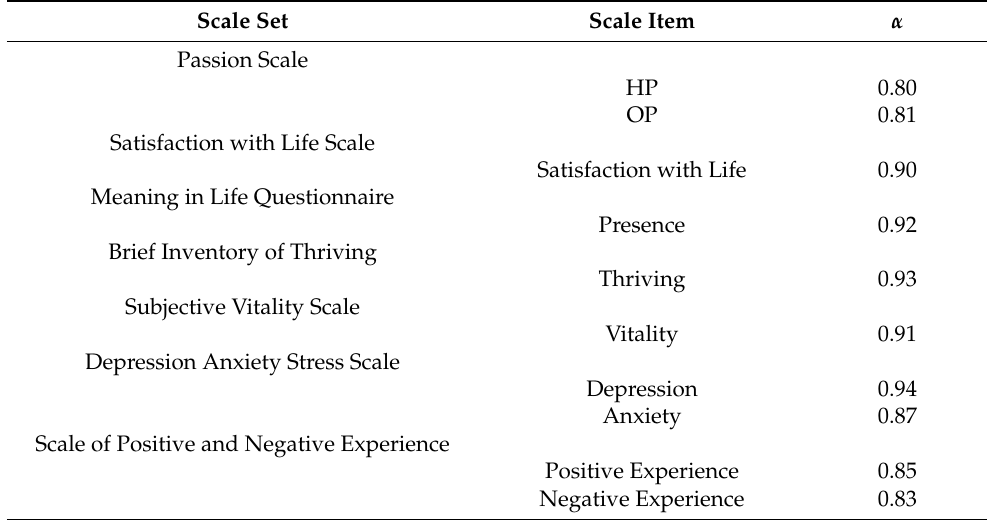
Table A1. Internal Consistency Coefficients for Each Measure.